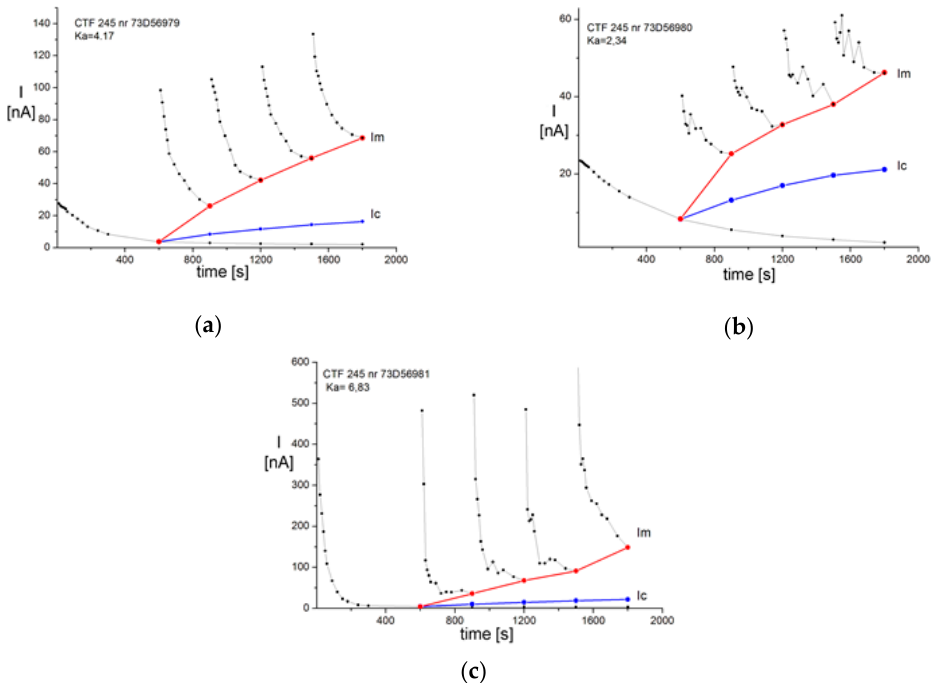
Figure 8. The SVM test results of CTF 245 kV bushings after 25 years of operation: ( a ) serial number 73D56979; ( b ) serial number 73D56980; ( c ) serial number 73D56981 [16].